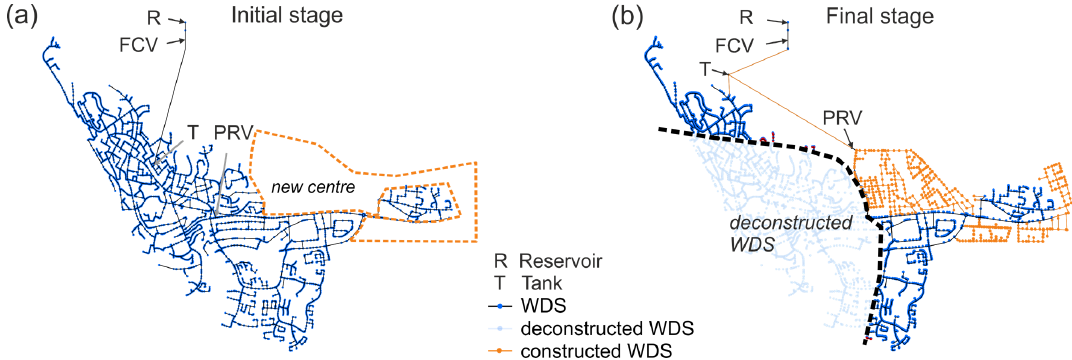
Figure 7. One of thirty created planning options representing ( a ) the initial and ( b ) the final stage.